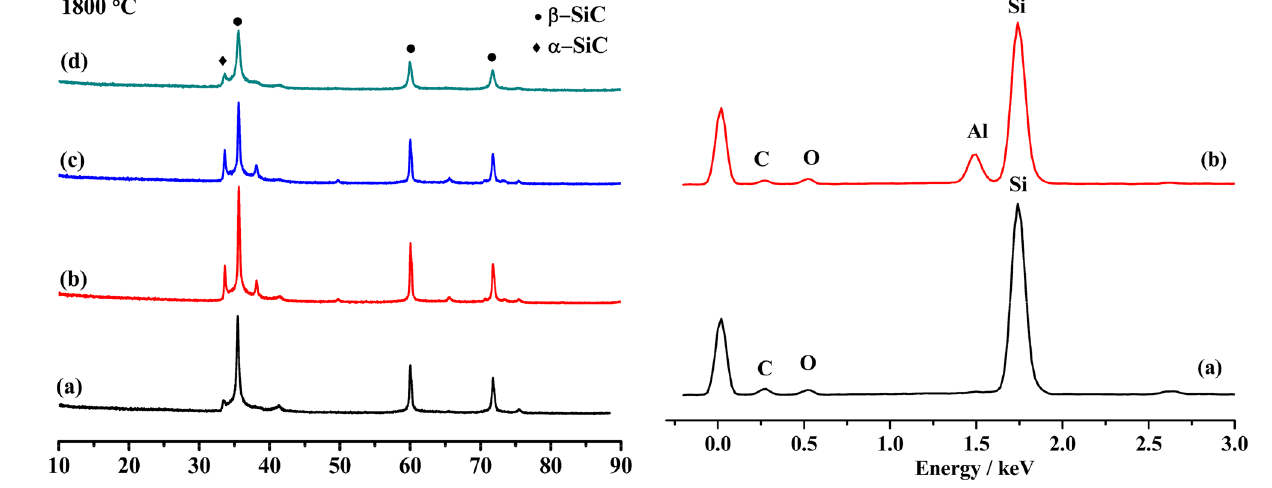
Figure 11: XRD patterns of 1,800°C ceramics derived from ( a ) AHPCS, (